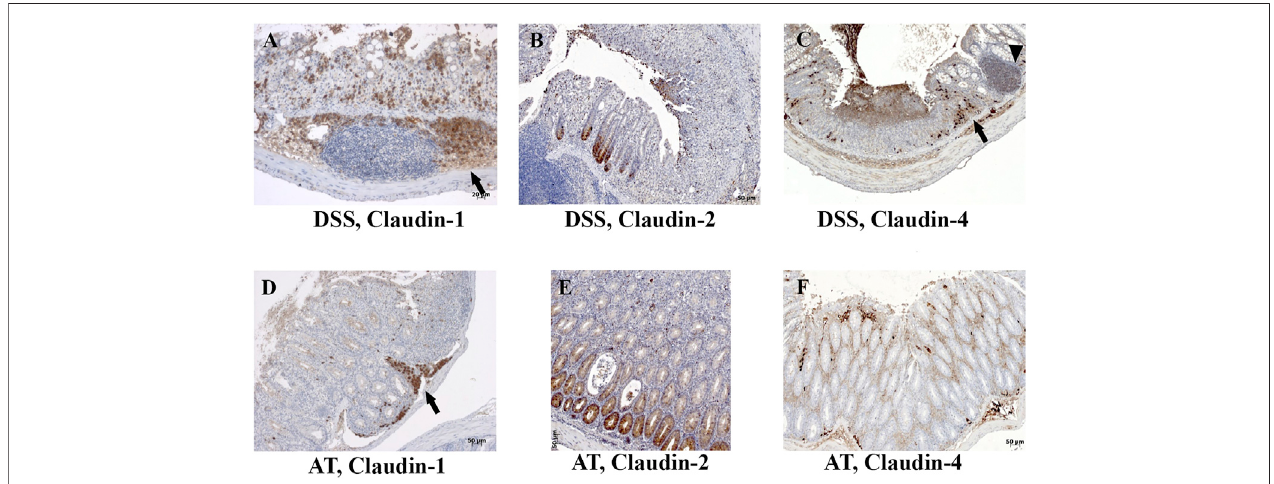
FIGURE11| Claudin-1,claudin-2,andclaudin-4expressionbymononuclearsandwithinlymphnodesinIBDanimalmodels. (A) Claudin-1(IHC),DSS; (B) claudin- 2 (IHC), DSS; (C) claudin-4 (IHC), DSS; (D) claudin-1 (IHC), adoptive transfer, 6 weeks after transfer; (E) claudin-2 (IHC), adoptive transfer, 6 weeks after transfer; (F) claudin-4 (IHC), adoptive transfer, 8 weeks after transfer. Highlighted features: lymphoid follicle (arrowhead) and accumulation of macrophages (arrows). AT, adoptive transfer